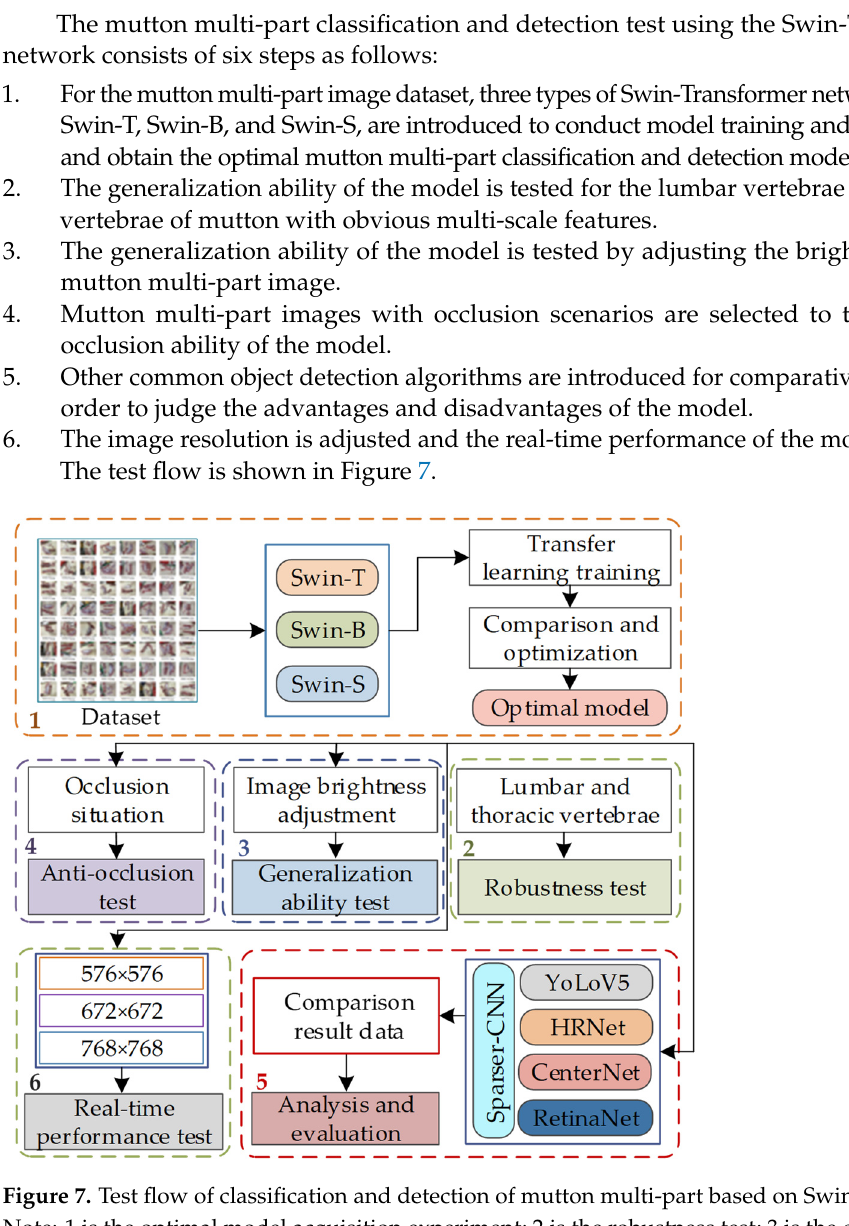
Table 2. Parameters of three Swin-Transformer network variants.